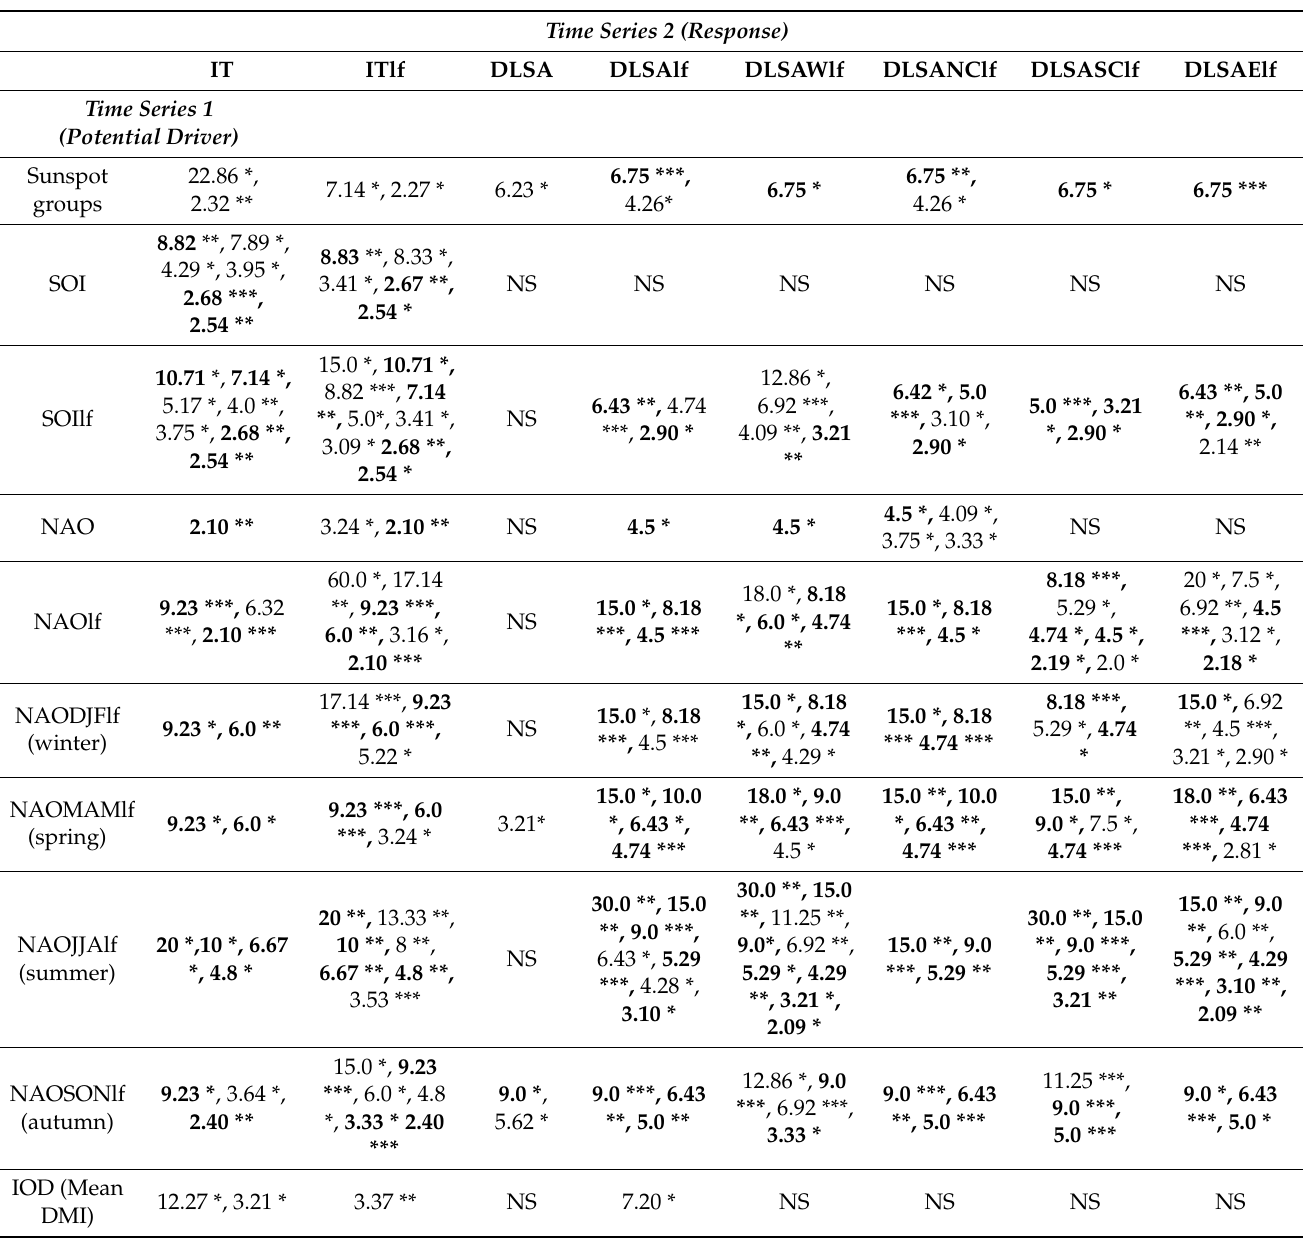
Table 3. Spectral coherence results between Desert Locust time series and oceanic indices and sunspots. All statistically significant values of coherent cycle lengths are presented. Significant results are denoted * for p < 0.05; ** for p < 0.01; *** for p < 0.001. IT = Inferred Desert Locust series (1866–2014 [or 2010 for link with sunspots]); ITlf = low frequency component of IT; DLSA = 1 ◦ gridded data (1930–2014); DLSAlf = low frequency component of DLSA, followed by the same for regional data (W = West; NC = North Central; SC = South Central; E = East). SOI = Southern Oscillation Index; NAO = North Atlantic Oscillation; IOD = Indian Ocean Dipole; NAOlf = low frequency component of NAO, followed by seasonal data. Frequencies common to at least two pairs of time series in a row are highlighted in